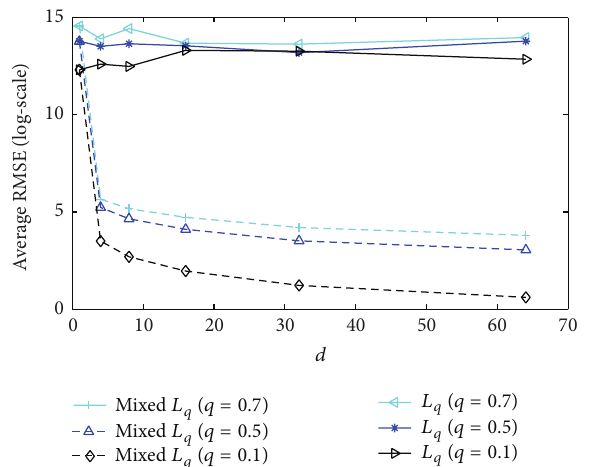
Figure 2: Plots of average RMSE (log-scale) versus block size, for the use of the mixed 𝑙 2 /𝑙 𝑞 and the standard 𝑙 𝑞 minimization methods with different values of 𝑞